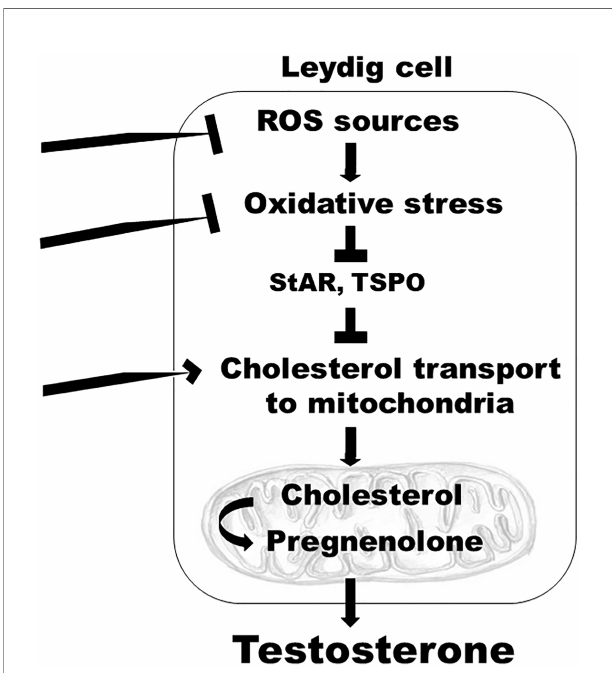
FIGURE 1 | A model depicting mechanism-speci fi c endogenous targets within the Leydig cells of the testis which can be modulated to reverse hypogonadism in SCD. Targets include: inhibition of enzymatic sources of oxidative stress, such as NOX; inhibition of increased oxidative stress, which decreases protein synthesis of enzymes involved in cholesterol transport to the mitochondria, such as StAR and TSPO; stimulation of cytosolic or outer mitochondrial membrane protein components involved in cholesterol transport from intracellular stores to the inner mitochondrial membrane; ROS, reactive oxygen species; StAR, steroidogenic acute regulatory protein; TSPO, translocator